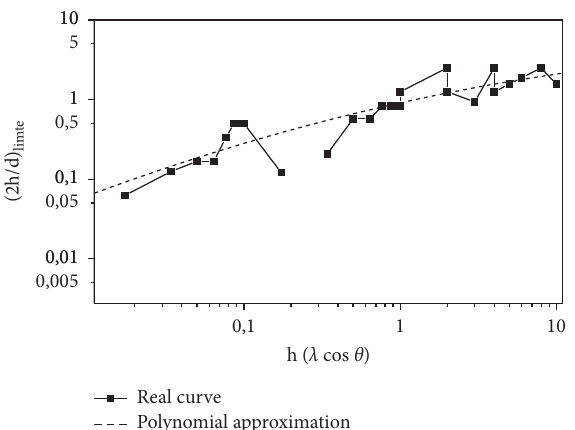
Figure 4: Limit ratio (2 h / d )